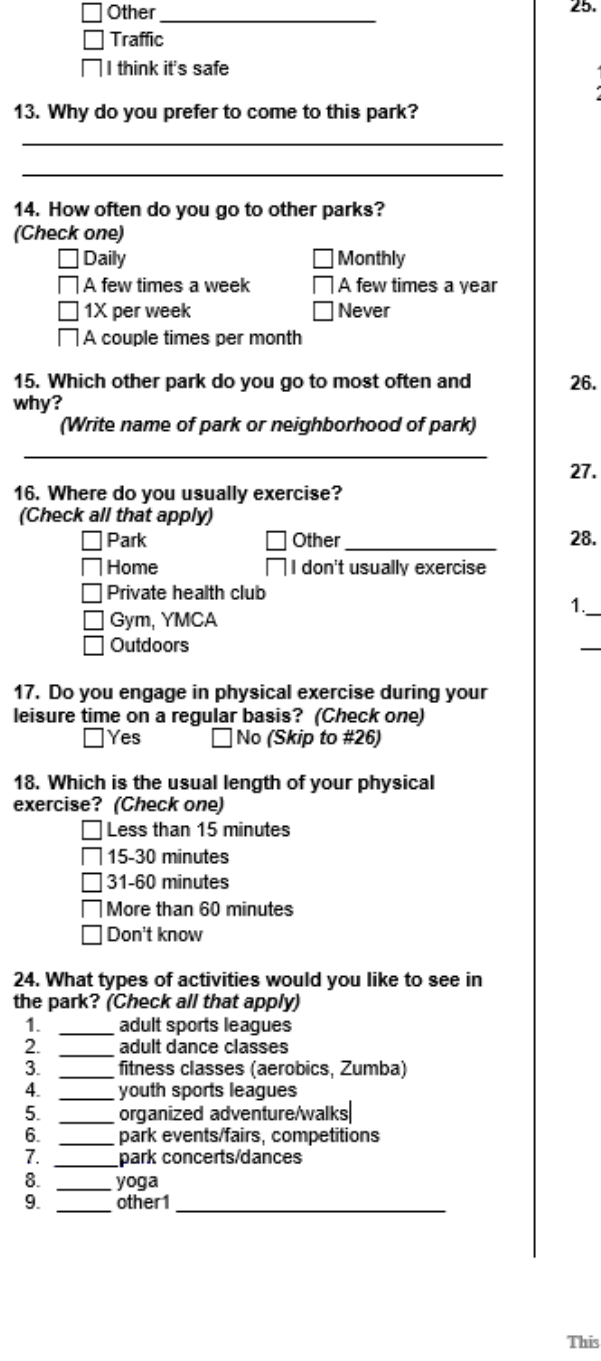
Figure A1. Park Intercept